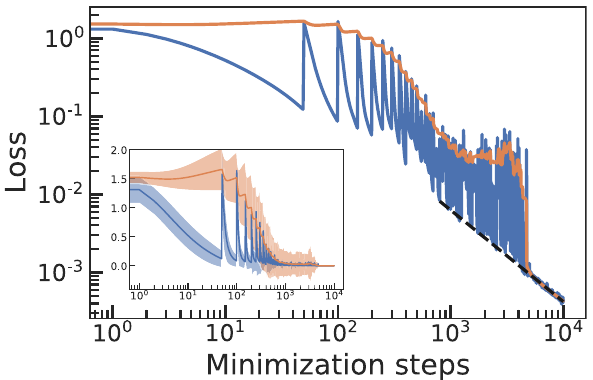
Figure 4. Learning one sample at a time, mean values for the training and test loss. We repeat the same protocol described in Fig. 3 for 70 different runs. Again, the model is trained using a different random example every 50 steps. For each run we start with a different initialization and choose different training examples at random, the test dataset is the same for all the simulations. The blue and orange lines correspond to the mean value of the training and test loss, respectively. The inset presents the same data in a semi-log scale, including a shaded area around each curve that represents one standard